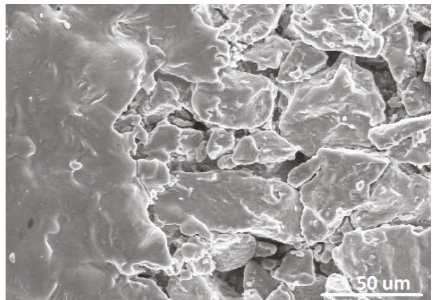
Figure 7: SEM showing the edge of sintered titanium. Unsintered particles to the right were not irradiated with the laser beam.